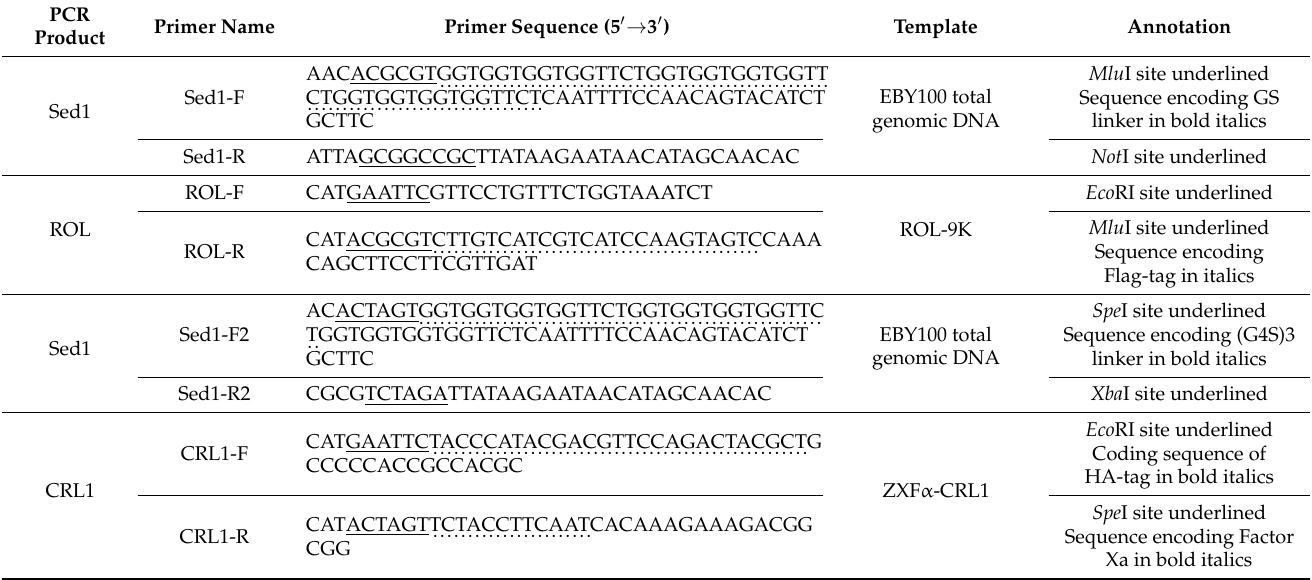
Table 1. Primers used in the present